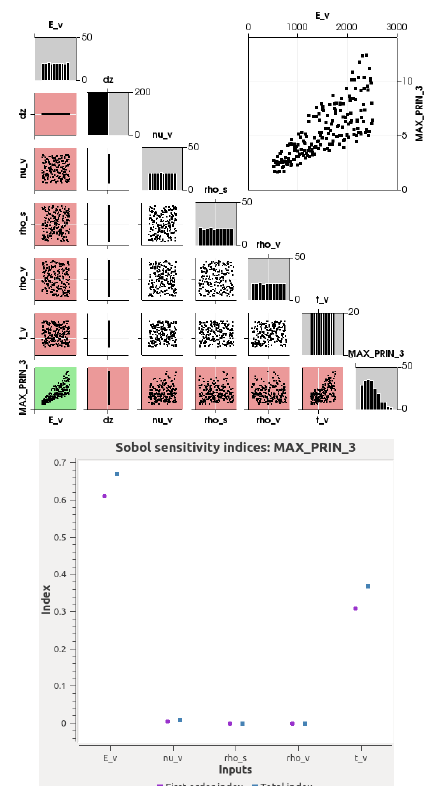
Figure 11. 200 LHS simulations for the middle layer maximum principal stress (the sensitivity, calculated with the Sobol indices, is reported